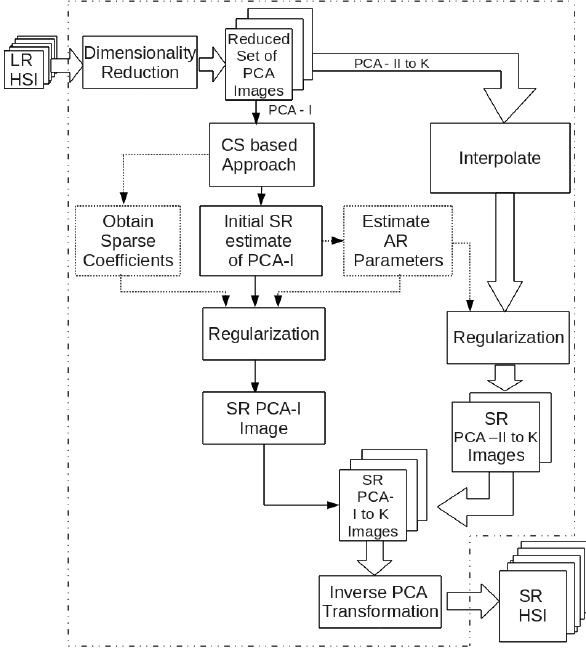
Figure 1: Block diagram of HS image